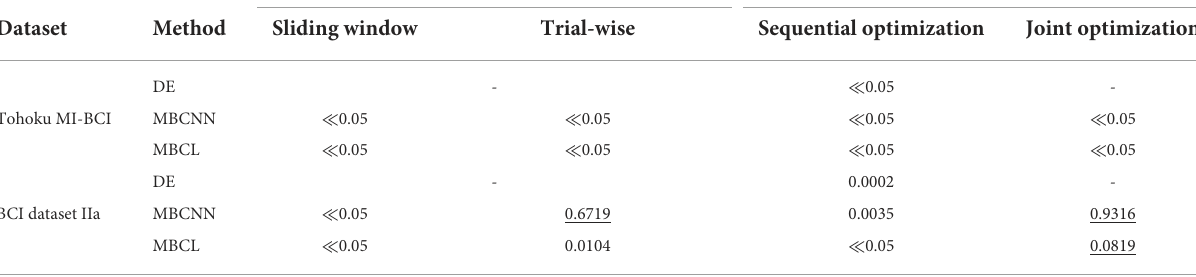
TABLE 5 Statistical significance ( p -value) of methods under different training schemes, where underlined values indicate no significant statistical difference. Sequential optimization vs. joint optimization